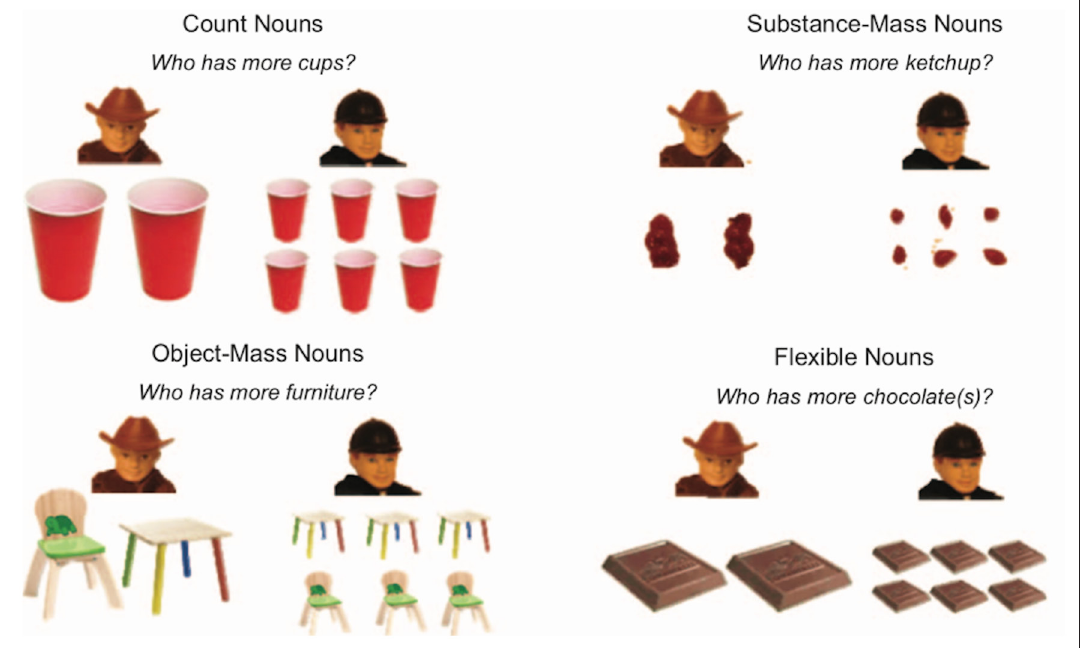
Figure 1: Sample stimuli, quantity judgment tasks (Barner, Li & Snedeker 2010: